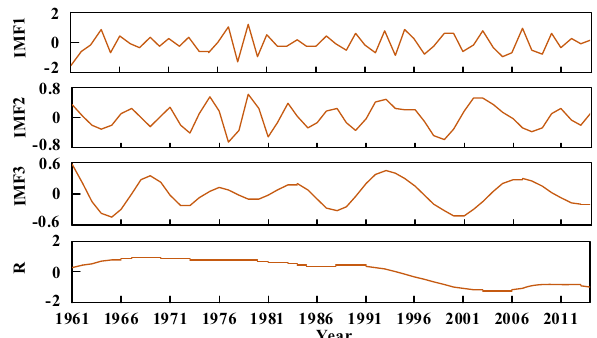
Fig. 3 The intrinsic mode function (IMF) and trend components of annual scale standardized precipitation evapotranspiration index (SPEI) values based on extreme-point symmetric mode decomposi- tion (ESMD) in the lower reaches of the Heihe River Basin during